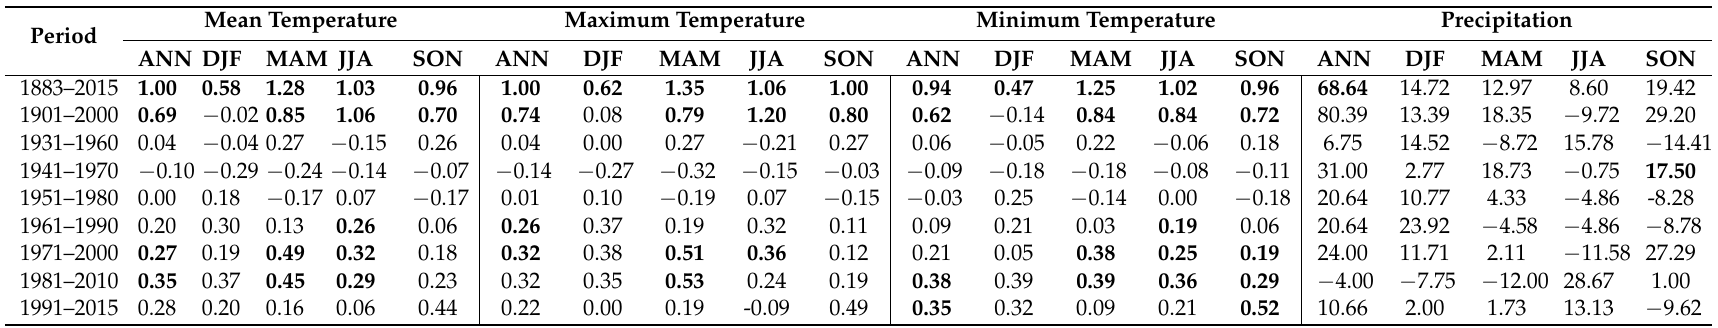
Table 5. Trend rates in mean temperature, TX, TN and precipitation for standard climate periods as in [17,18] ( ◦ C, Days, % or mm per century for 1883–2015 and